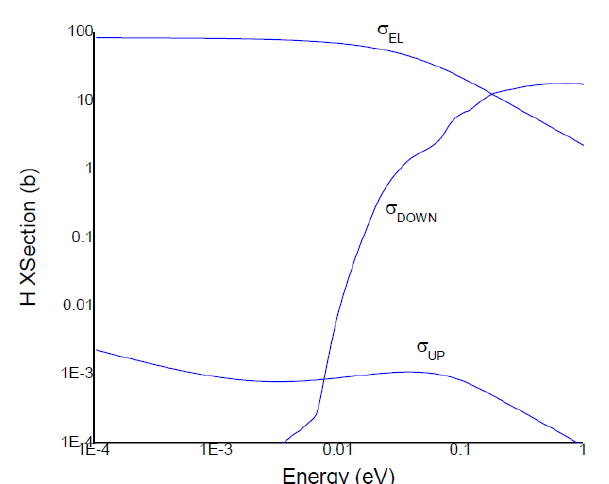
Fig. 9 : The scattering components of the total cross section of H in MgH 2 at 20K.